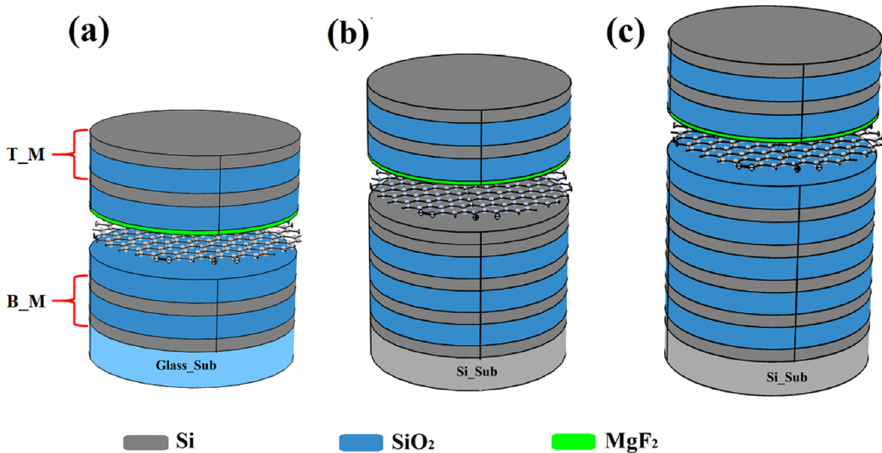
Figure 1. Scheme of the Fabry–Perot filters embedding SLG: ( a ) symmetric FP (FP1), ( b ) asymmetric FP (FP2) and ( c ) asymmetric reflective FP (FP3). T_M and B_M stand for top and bottom mirrors.